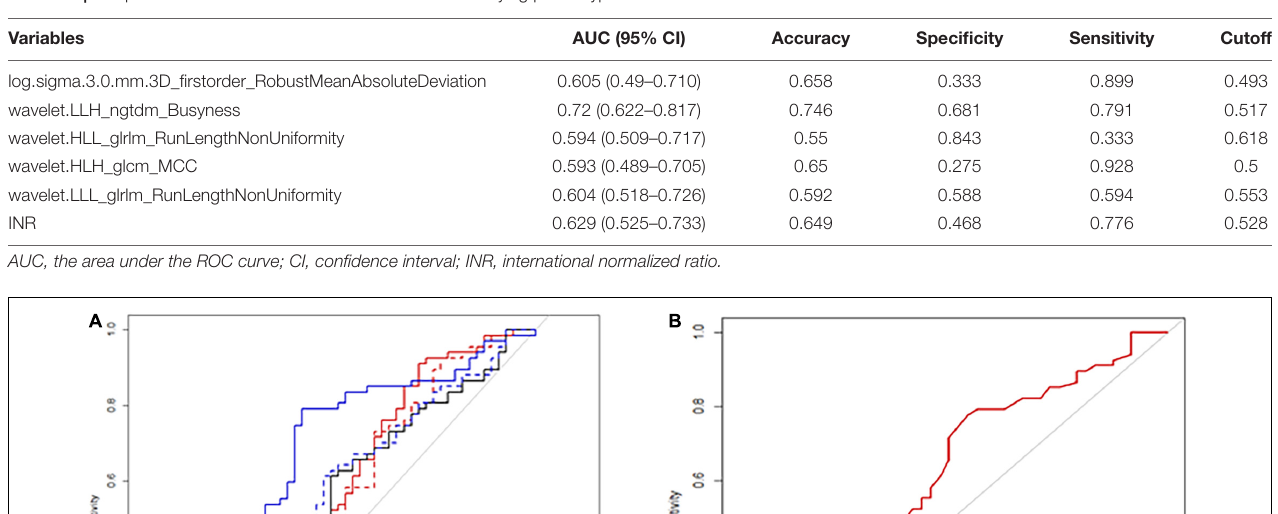
TABLE 3 | The performance of texture features and INR for stratifying portal hypertension.